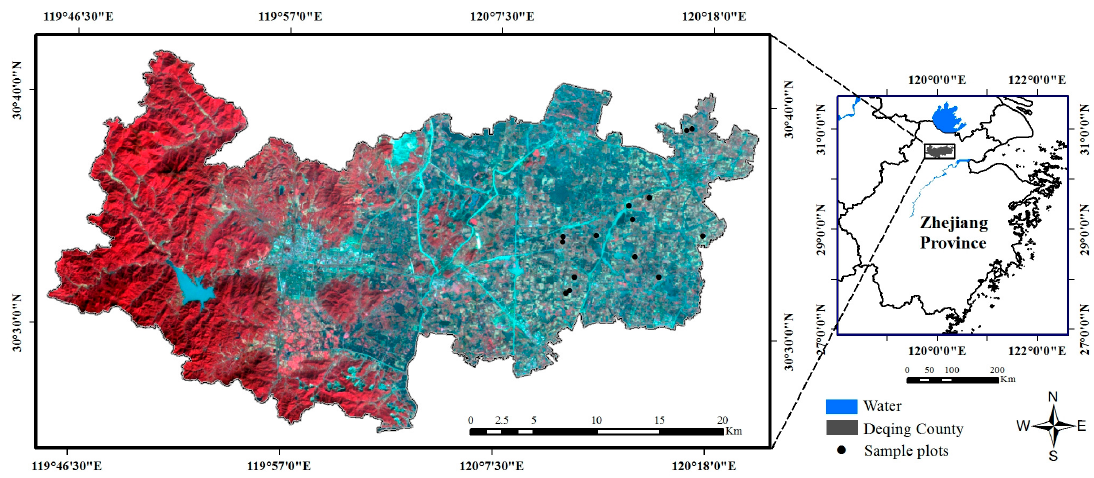
Figure 1. HJ-1A charge-coupled device (CCD) false-color composite image of the study area of Deqing County, Zhejiang Province, East China.